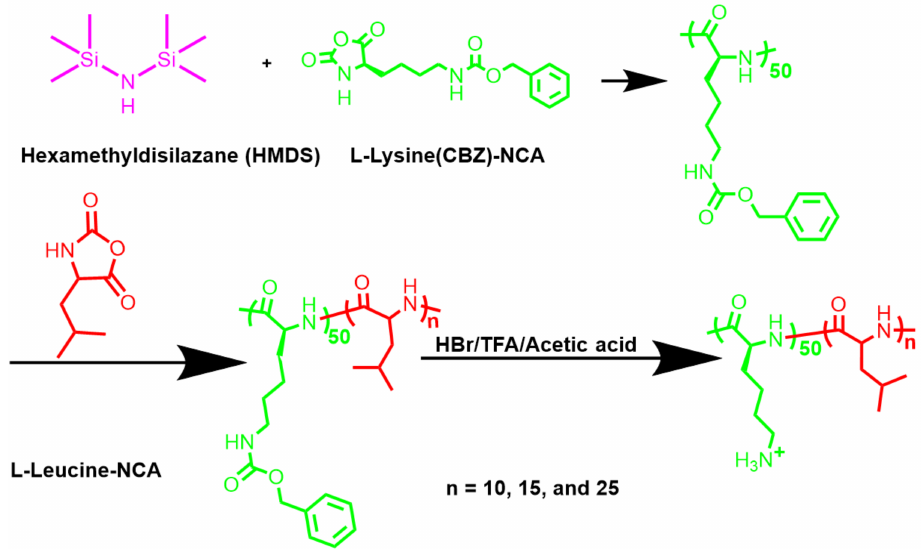
Figure 1. Synthesis route of controlled di-block amphiphilic poly( L -lysine) 50 - block -poly( L -leucine) n